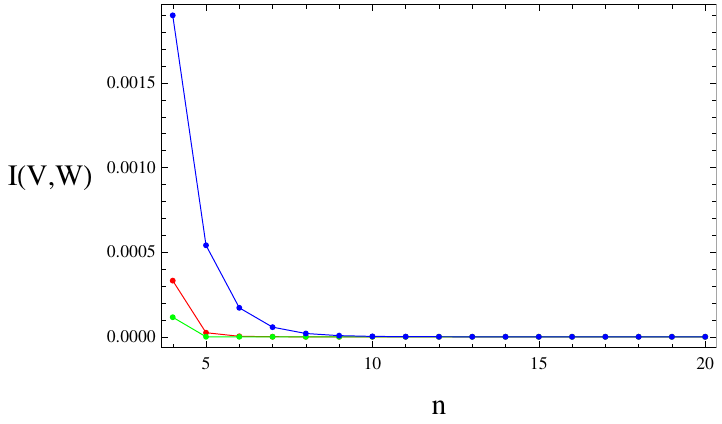
Figure 23 . The mutual information of gauge (cid:12)elds coupling with matter between two squares of equal sizes separated by a distance equal to the square size for algebra ~ B with m = 1 line), m = 1 (red line) and m = 2 (green line).